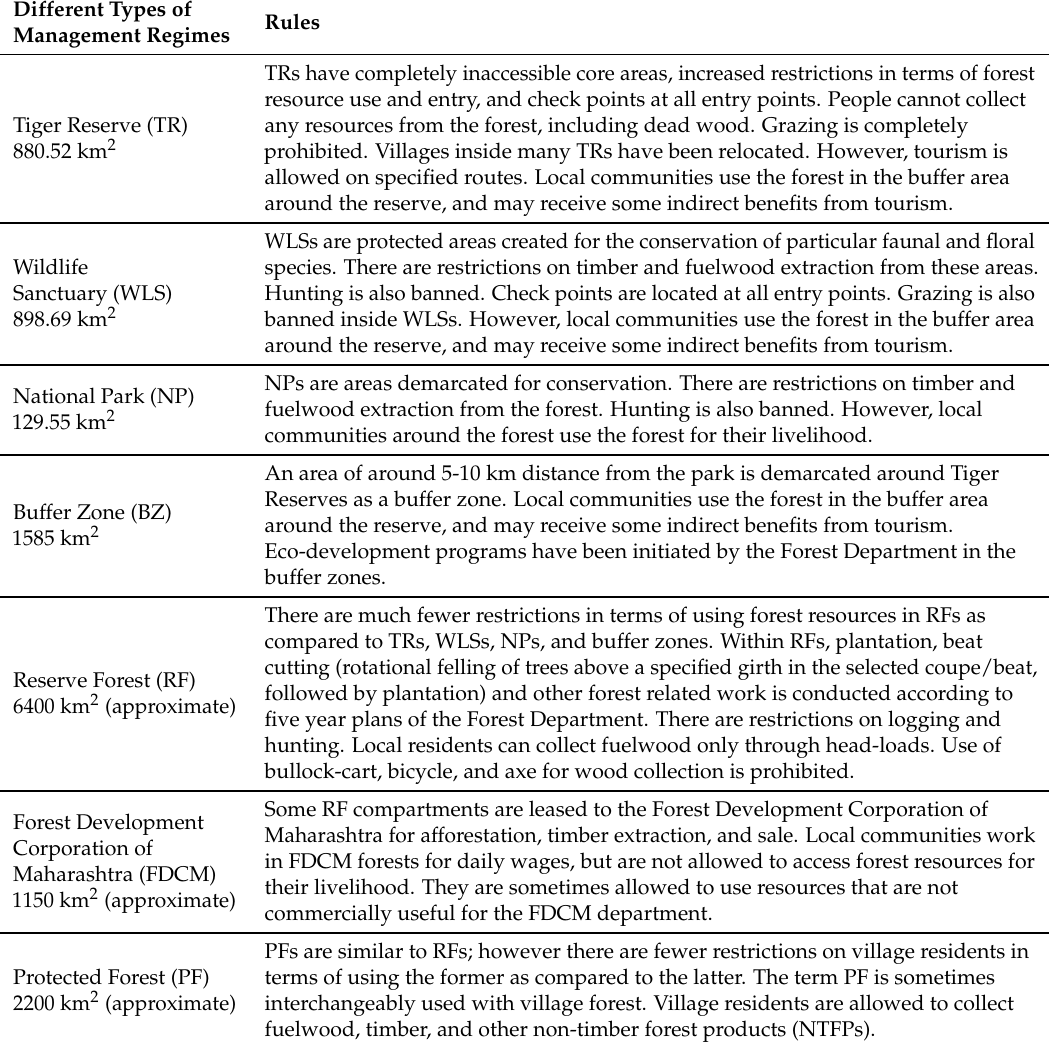
Table 1. Types of forest management regimes and the rules of use and